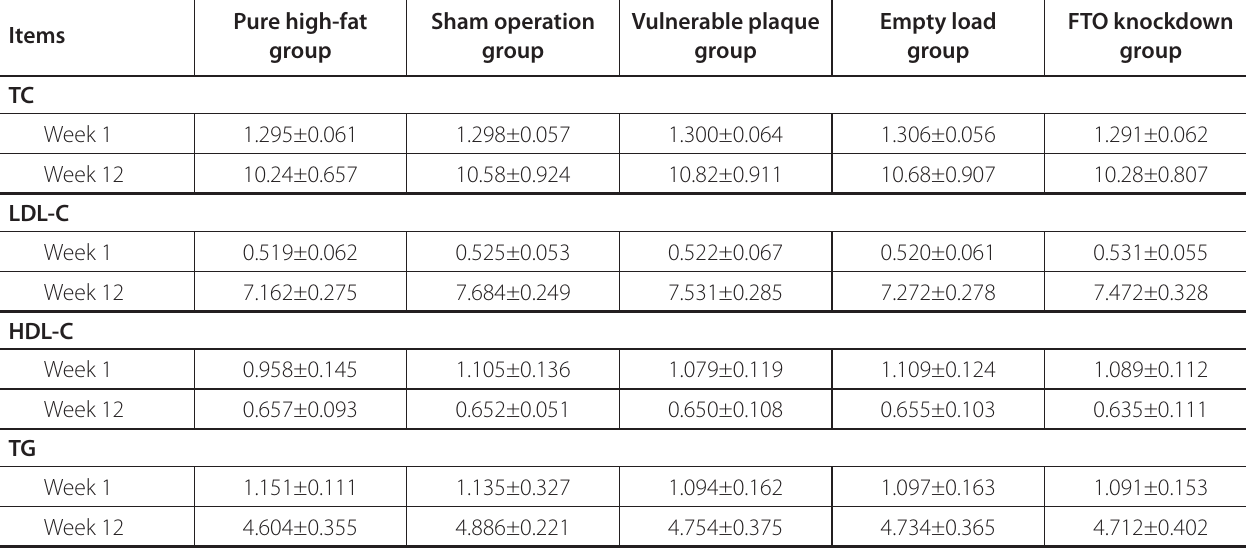
Table 1 . Levels of TC, TG, HDL-C, and LDL-C in the five groups (mmol/L).